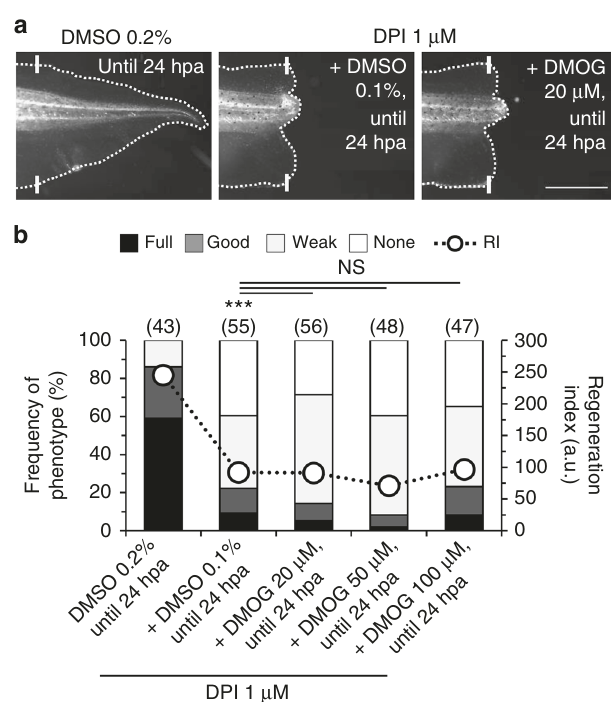
Fig. 6 ROS do not directly stabilize HIF-1 α to modulate regeneration. a , b Stabilization of HIF-1 α does not rescue DPI-impaired regeneration. a Representative tails at 7 dpa in vehicle-control and pharmacological treatments from tadpoles amputated at st. 40 – 41. b Qualitative and quantitative analyses of regeneration ef fi ciency for the different conditions tested. White solid lines: amputation plane; scale bar: 1 mm. RI regeneration index; a.u. arbitrary units. Statistical analyses were performed by Fisher ’ s exact test (two-tailed p -value). n biological replicates indicated in brackets. NS non-signi fi cant; *** p <